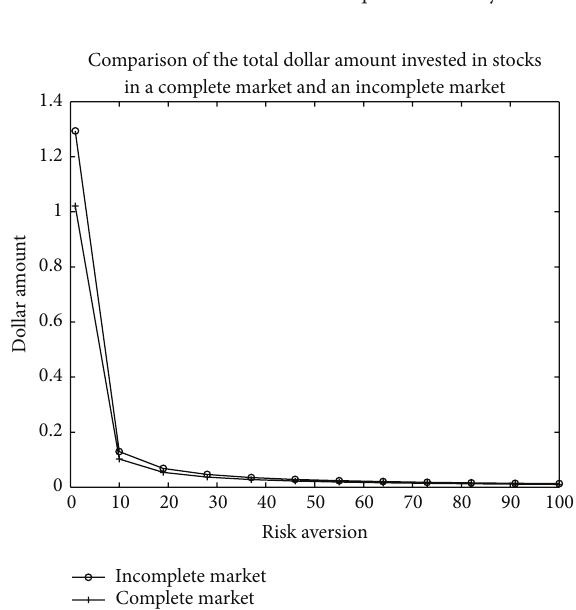
Figure 1: Transaction cost for quadratic utility.